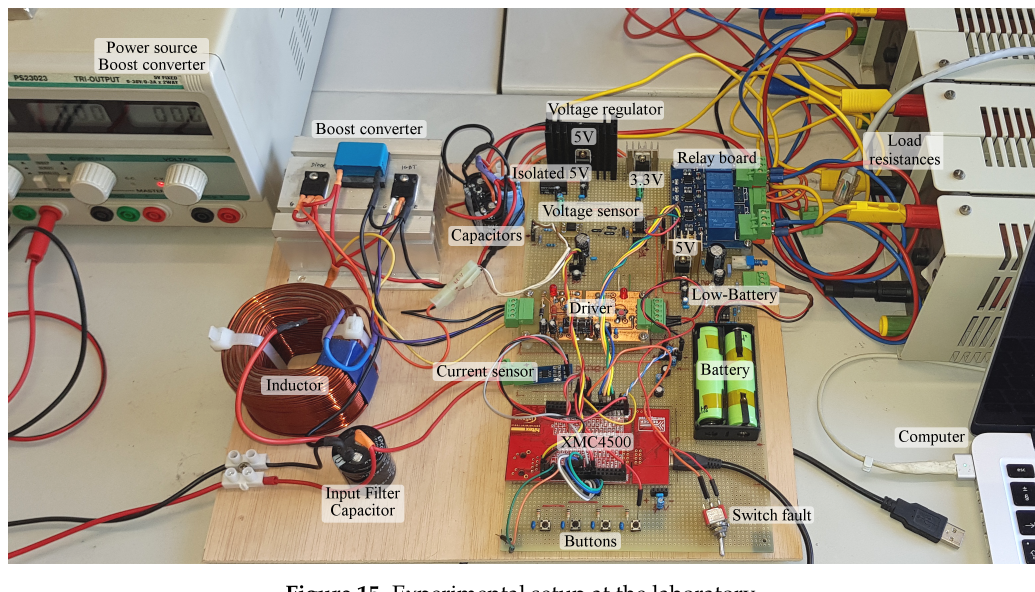
Figure 15. Experimental setup at the laboratory.